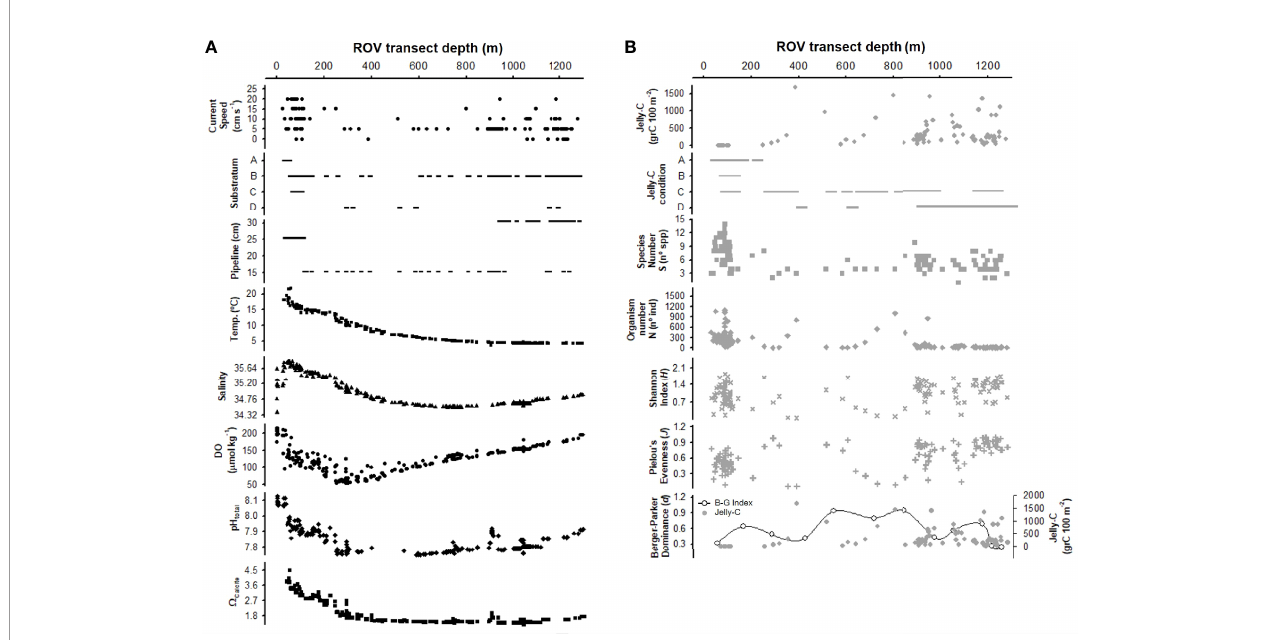
FIGURE 3 | Broad-scale vertical comparison of abiotic and biotic variables along the bathymetric gradient. Abiotic (A) and biotic (B) variables used with 100-m 2 transect data. Data were dependent upon the information available from remotely operated vehicle (ROV) videos: current speed, substratum (A, pipeline/land material; B, pipeline/ fi ne sediment; C, pipeline/coarse sediment; D, pipeline/disturbed sediment), pipeline size, jelly-C per unit area, jelly-C condition (A, no jelly-C; B, fresh jelly-C; C, degraded jelly-C; D, decomposing jelly-C), species number (S), organism number (N), Shannon index ( H ), Pielou ’ s evenness ( J ), and Berger – Parker dominance ( d ) , and the environmental data obtained from the water column surveys (temperature, salinity, dissolved oxygen (DO), pH total , and Ω Calcite ). All data were plotted in raw format (no transformation) using 100-m 2 -sized sampling transects to provide an overall view of the